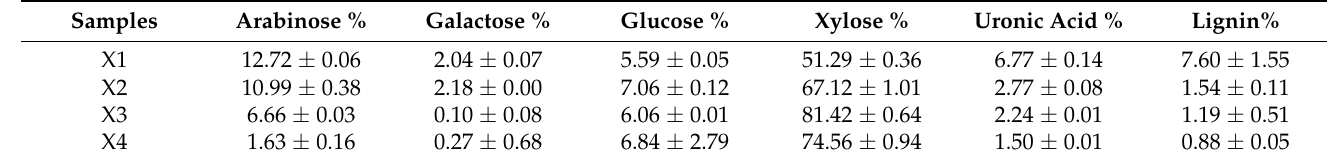
Table 2. Chemical compositions of the xylan separated through different extraction methods. Samples Arabinose %